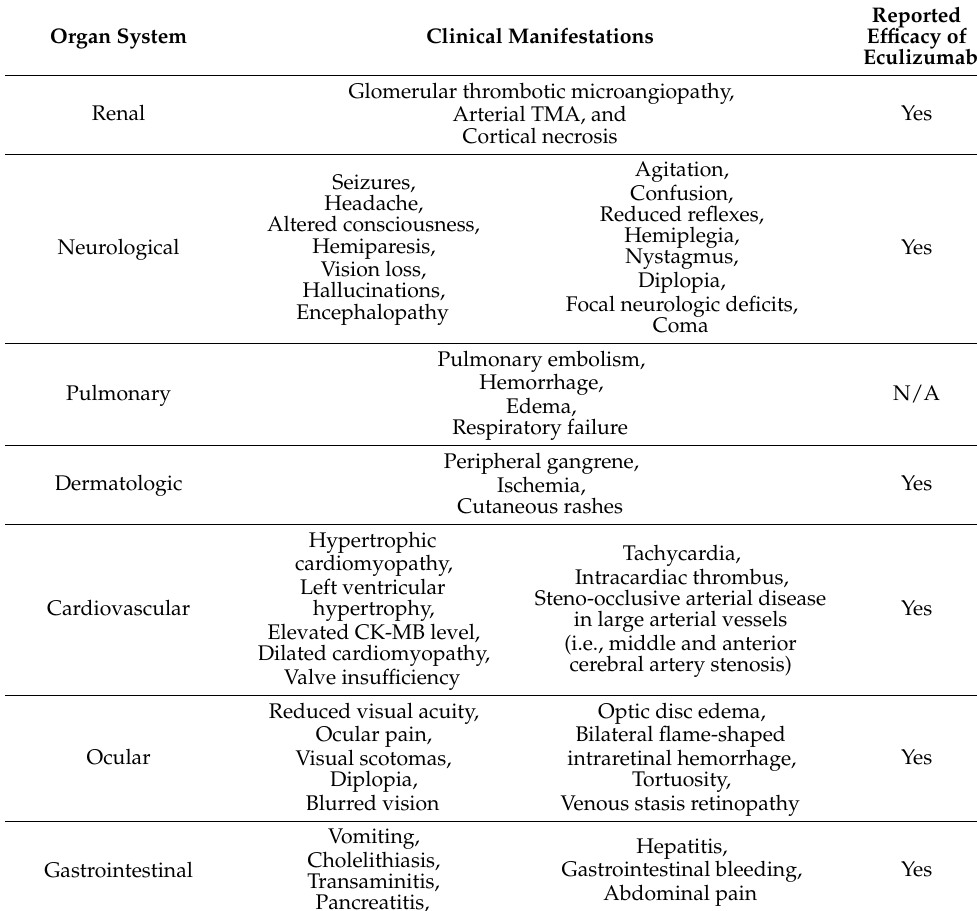
Table 3. Clinical manifestations of aHUS based on organ